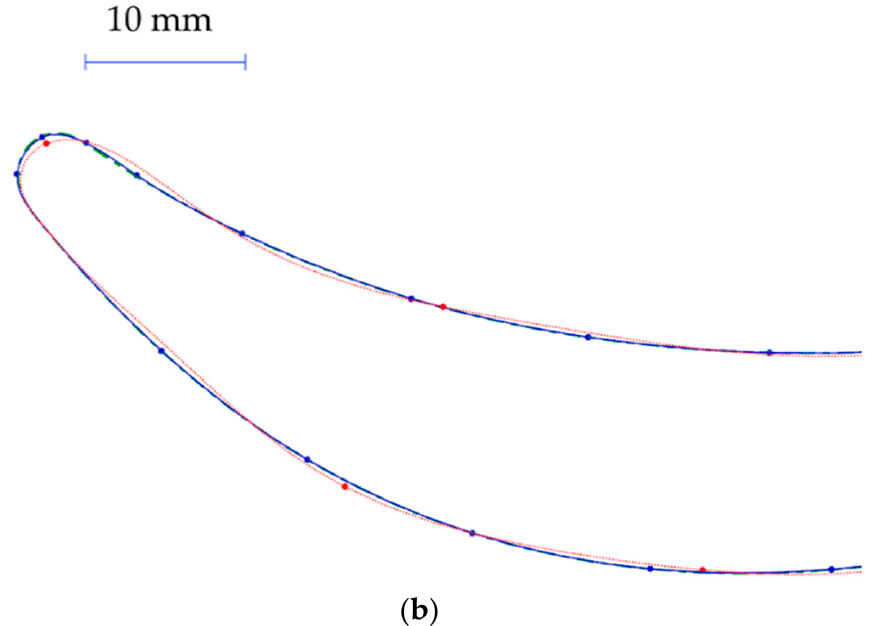
Figure 9. Spline interpretation based on 10 significant points (red-dashed), 25 (blue-straight) vs. the original spline (green dotted-dashed). ( a ) Turbine guide vane. ( b ) Turbine blade.